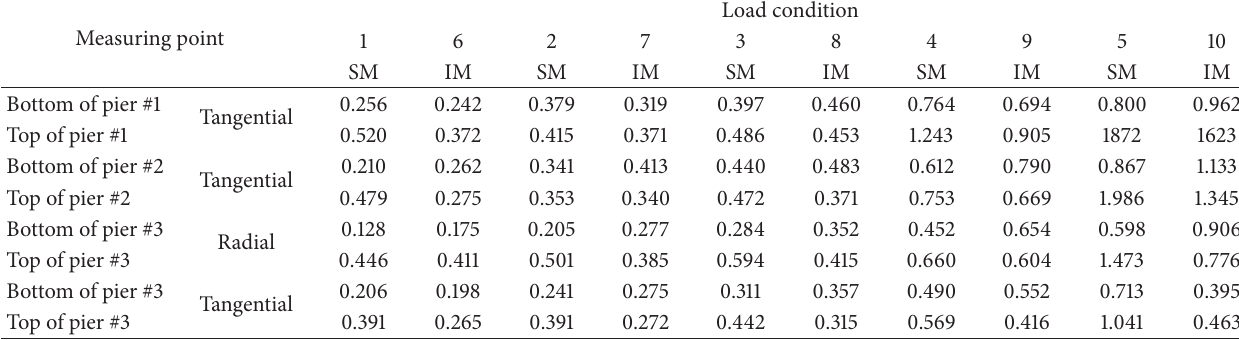
Table 5: Peak acceleration of measuring points (unit: